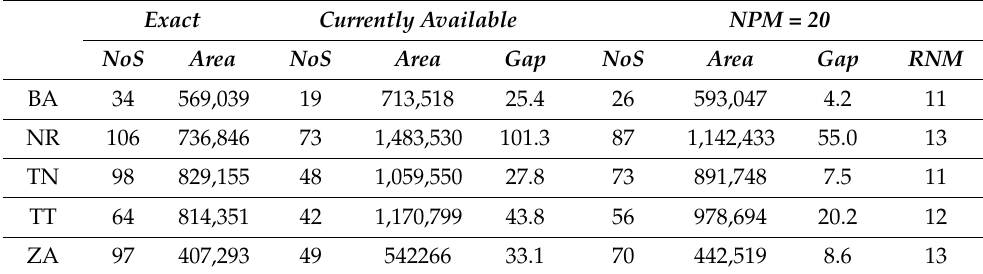
Table 2. Summary of results obtained for selected self-governing regions of Slovakia—part 1.